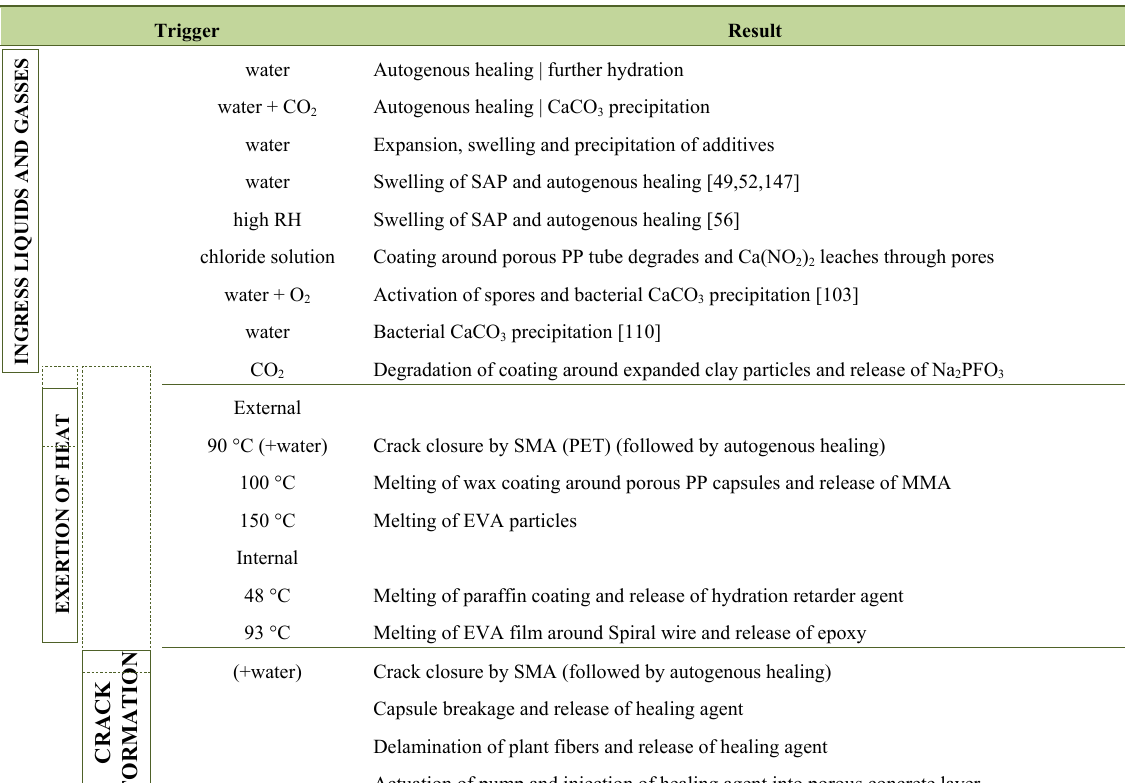
Table 3. Overview of the mechanisms which might trigger self-healing of